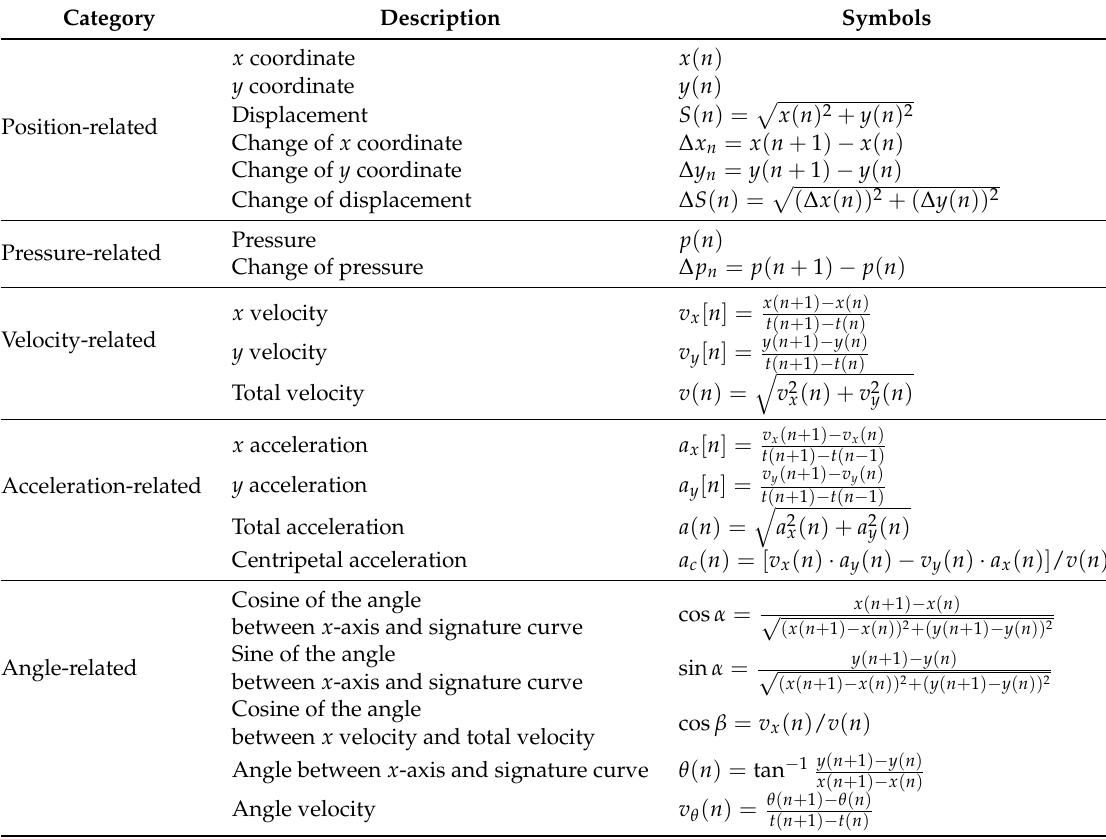
Table 1. Function features extracted for online signature